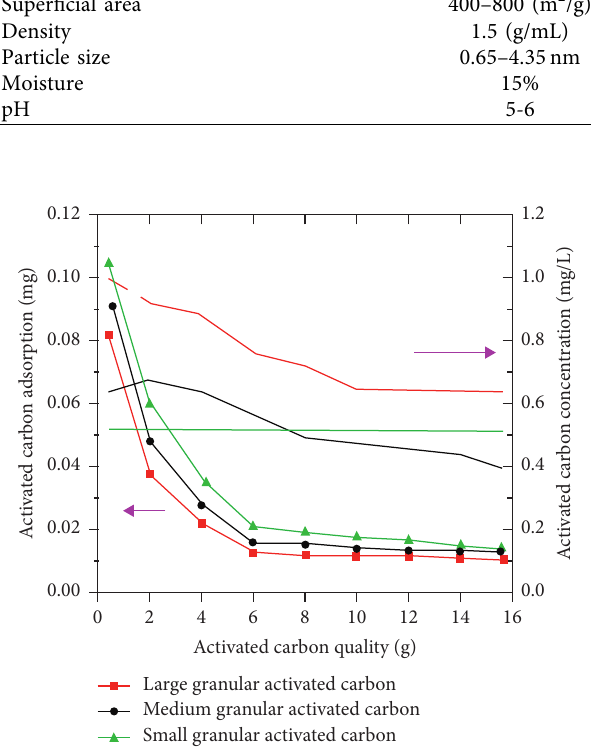
Figure 3: Adsorption capacity of activated carbon with different particle